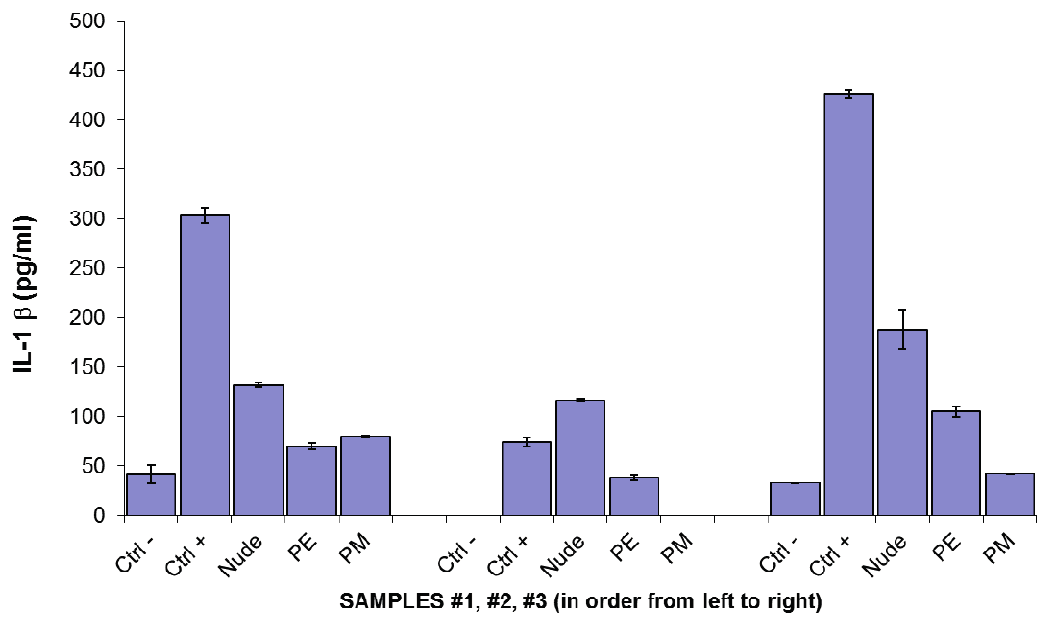
Figure 4. IL-1  release in a whole blood assay. Whole blood obtained by three different healthy donors was collected and incubated overnight in absence ( − ve controls) or in the presence of non-encapsulated (“nude”), polyester-encapsulated (“PE”) or polyimide-encapsulated (“PM”) sensors. +ve controls consisted of LPS. Results are expressed ±SD of three different culture